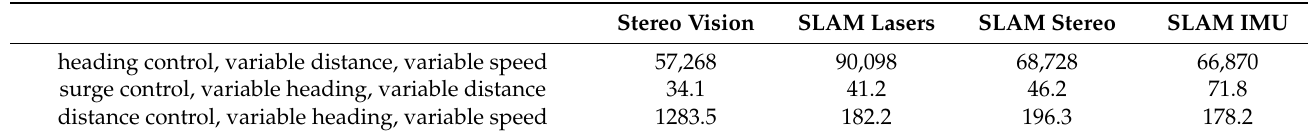
Table 5. Integral of absolute error for variable input signals.